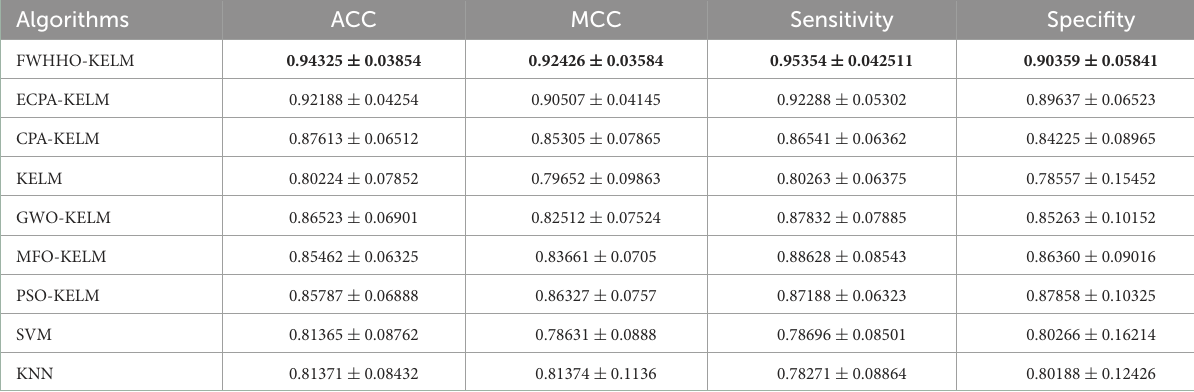
TABLE 8 The statistical study comparing outcomes in terms of the four criteria. Algorithms